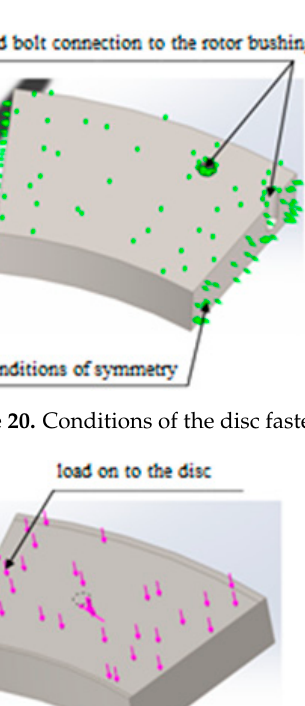
Figure 19. Actual defect and calculation grid for a defect on a disc segment.